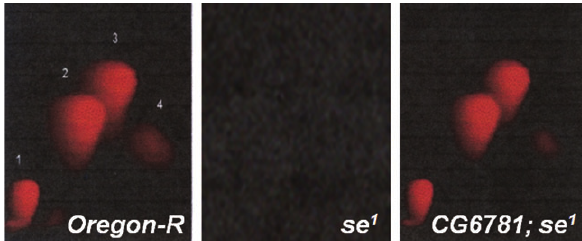
Figure 1 Genomic organization of the Drosophila GSTO genes. Four Drosophila GSTO genes are located on chromosome 3L. The CG6673 ( GstO2 ) gene has two alternative splice variants, isoforms A and B. The arrow indicates the direction of